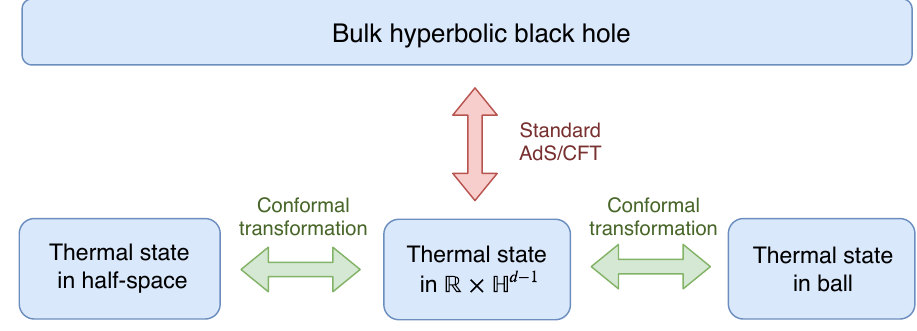
Figure 2 . Diagram representing the connection between the black hole with hyperbolic horizon and the localized thermal states in the half-space and a ball in Minkowski space-time. Through this series of maps the negative energy density of the localized states is mapped to the negative mass of the hyperbolic black